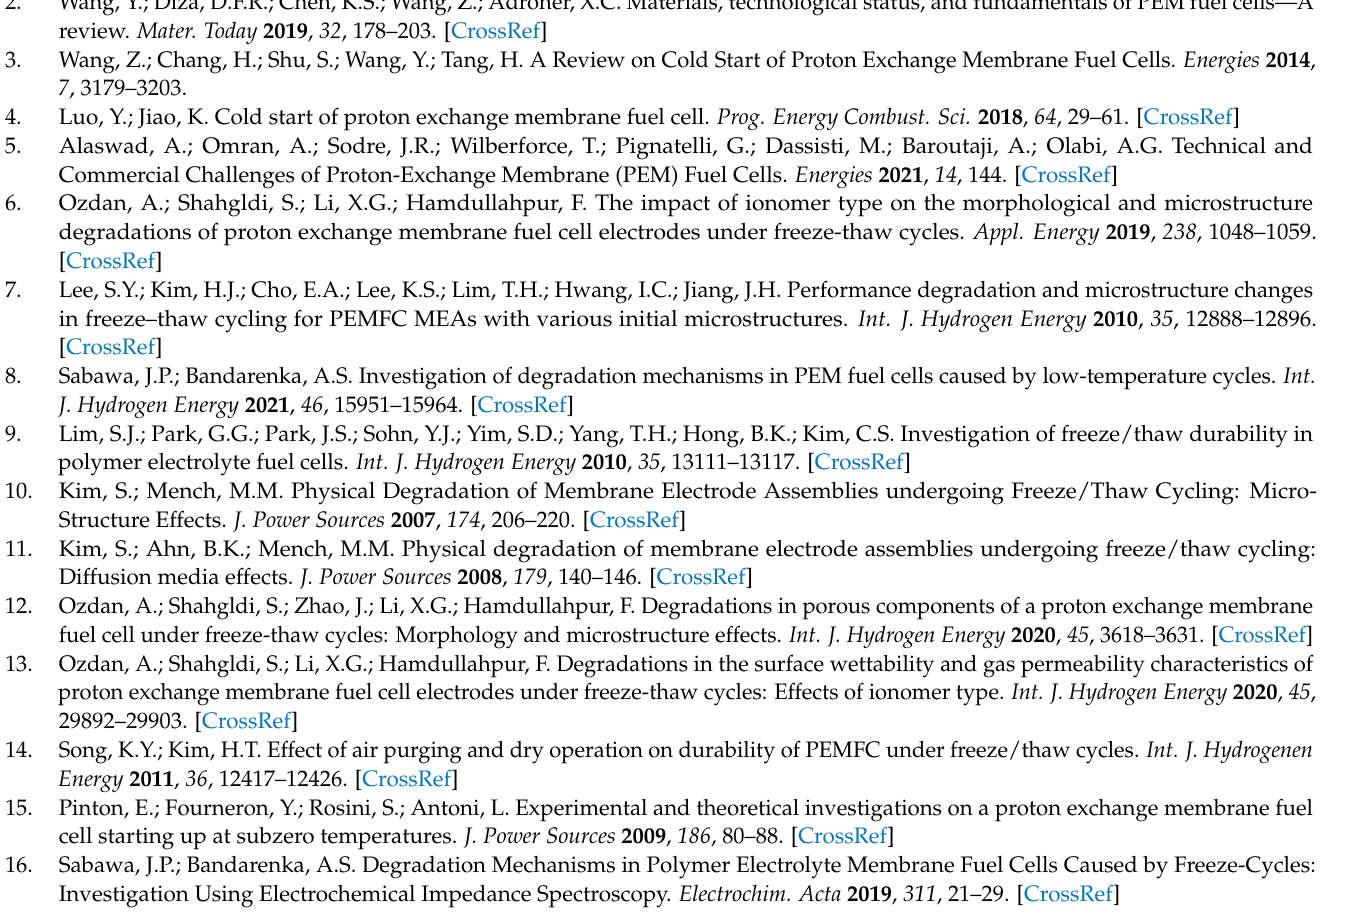
10.3390/en14144520/s1, Figure S1: Time evolution of HFR during equilibrium purge. Figure S2: Time evolution of cell temperature during cooling process. Figure S3: The characteristic curve of HFR during dry purge and relaxation. Figure S4: The HFR values after equilibrium purge with 100% humidified Nitrogen. Figure S5: The HFR of cell-2: (a) during dry purge and (b) after relaxation. Figure S6: The HFR of cell-3: (a) during dry purge and (b) after relaxation. Figure S7: The HFR of cell-5: (a) during dry purge and (b) after